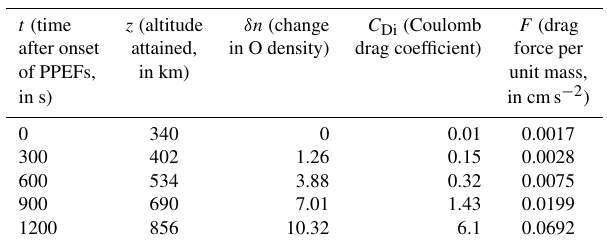
Table 1. Estimates of the altitude, z , attained by uplifted O atoms, relative change in O density, δn , Coulomb drag coefficient (extrap- olated from Chopra, 1961, and Li, 2011), C Di , drag force per unit mass on satellite, F , at different times, t , after the onset of a PPEF of 20mVm − 1 in a Carrington (1–2 September 1859) type super magnetic storm. The reference altitude is taken at z = 340km with the Earth’s magnetic field, B 0 = 0.35 × 10 − 4 T , and the oxygen atom (O) mass density mn o = 2.94361 × 10 − 14 gcm − 3 . The back- ground neutral O density is assumed to decrease exponentially with altitude with a scale height of H = 50km. The other parameters are neutral drag coefficient C D = 2.0, V s = 7.5kms − 1 , and area- to-mass ratio of satellite, A/M = 0.1cm 2 g − 1 , and the scale height, H =